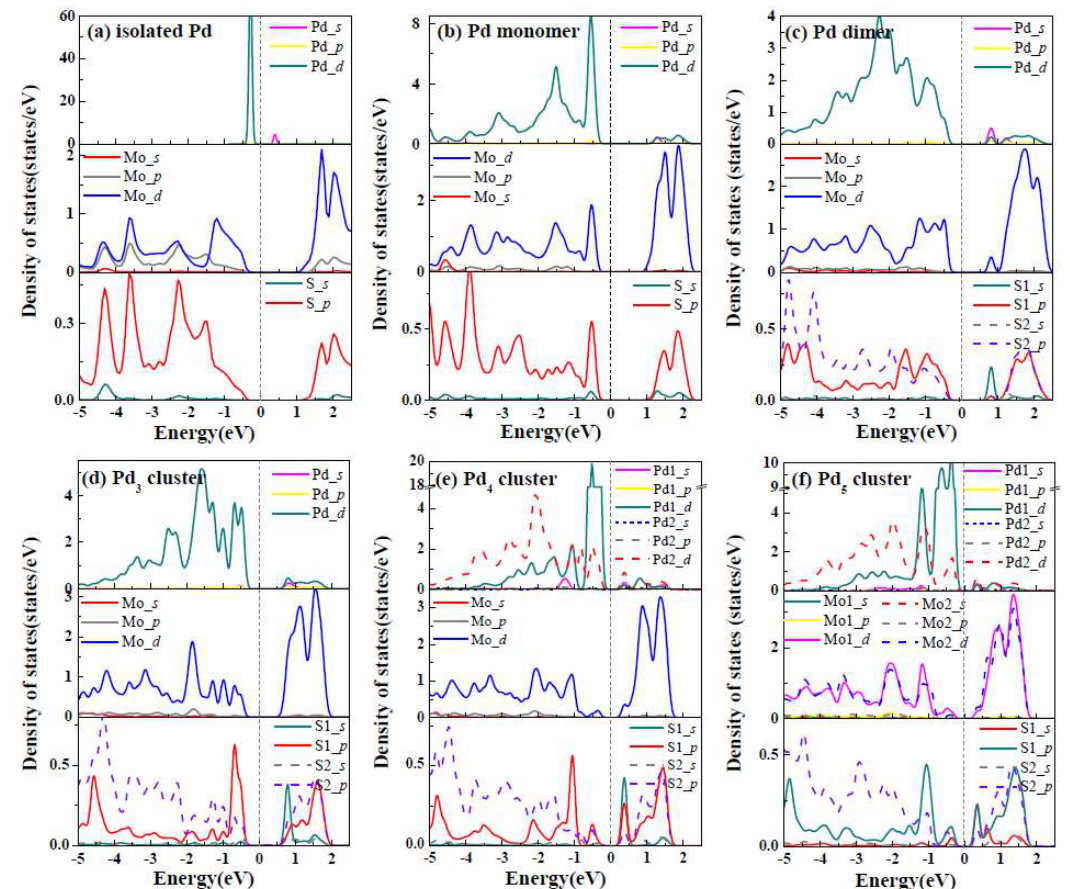
Figure 3. ( a ) Partial density of states (PDOS) of isolated Pd atoms and S and Mo of pristineMoS 2 ML. ( b – f ) PDOS of Pd adatoms of Pd n ( n = 2–5) clusters and surrounding S and Mo of underlying MoS 2 substrate. The Fermi level was set to 0 eV and is represented by the dashed lines.